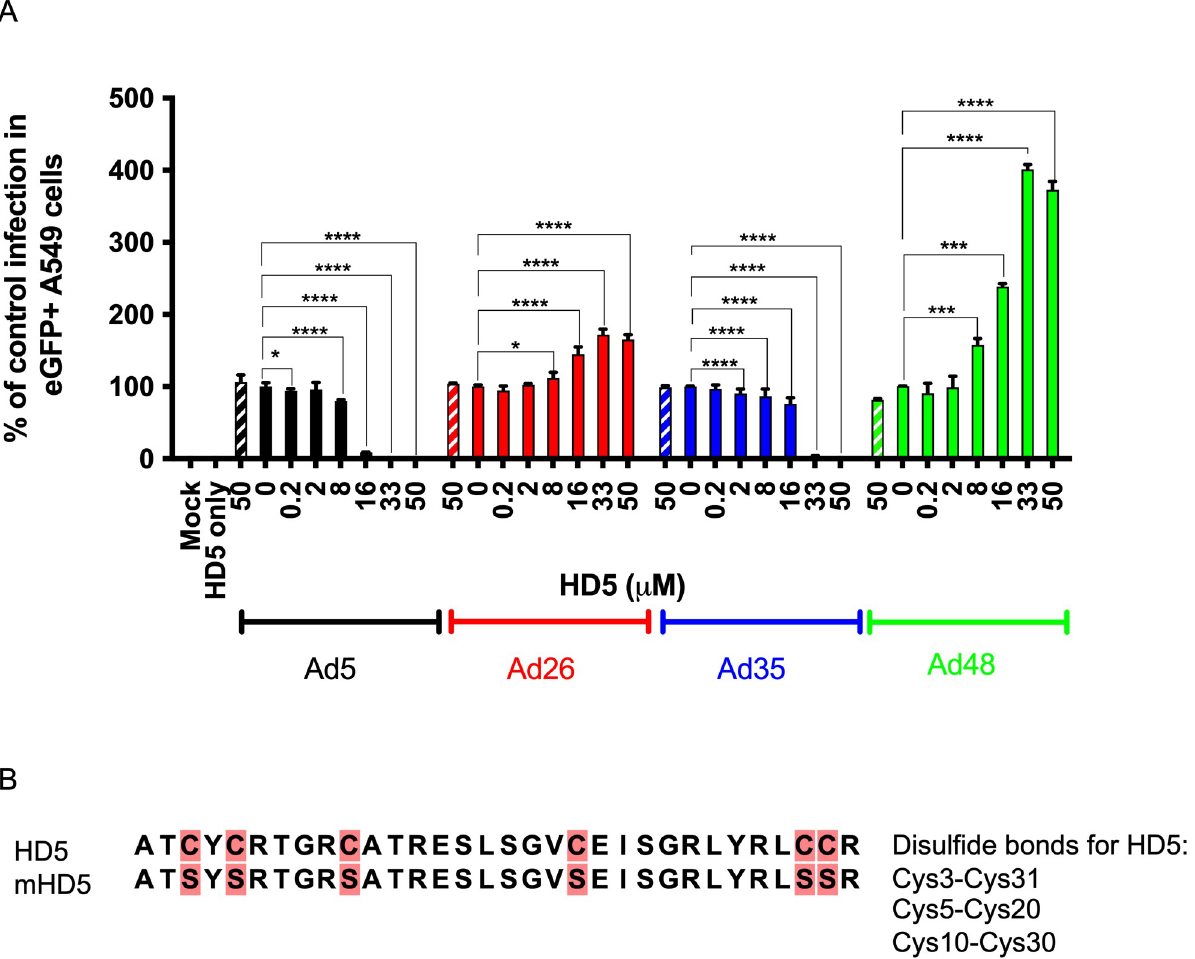
Fig 1. Analysis of adenovirus sensitivity to HD5 in A549 cells. Ad5, Ad26, Ad35, and Ad48 were incubated with 0.2 μ M– 50 μ M HD5 or 50 μ M mutant HD5 (diagonal box) and assessed for % of cells expressing eGFP 24 h post infection. Experimental results are normalized to control infected with virus (100%) in the absence of peptide. (B) HD5 and mHD5 amino acid sequence alignment. Cysteine ! Serine mutations are highlighted in pink. Data is expressed as the mean ( ± SD) of three independent experiments. ���� p < 0.0001, ��� p < 0.001, �� p < 0.01, � p < 0.05, one-way ANOVA test (compared to virus only